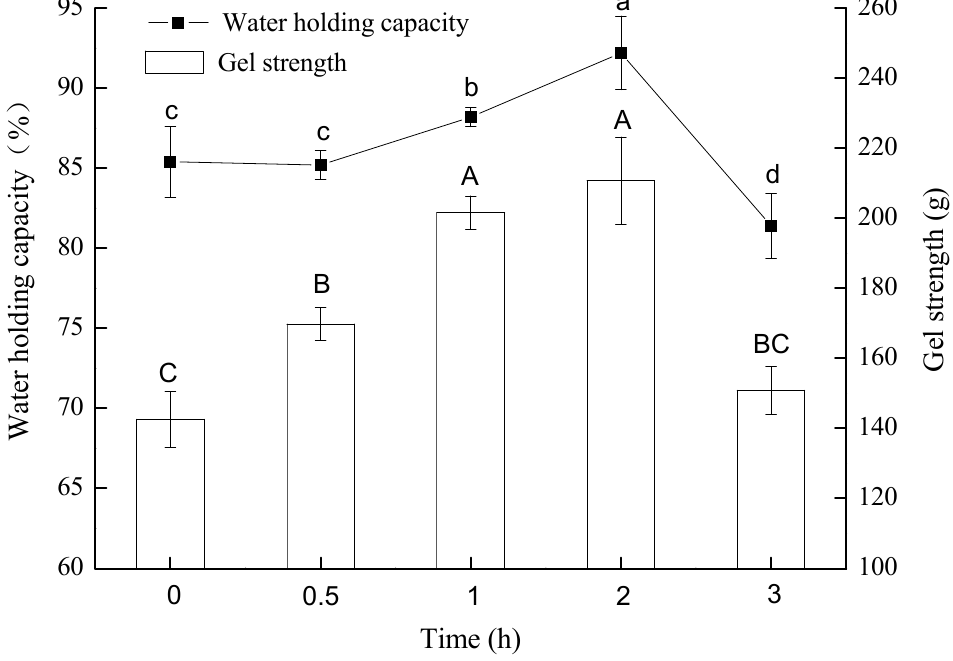
Figure 2. Changes in water holding capacity and gel strength of tofu prepared from soymilk with different TGase pre-crosslinking time spans (0, 0.5, 1, 2 and 3 h) and then coagulated by GDL. Means in the same plot that do not share a common superscript letter are significantly different ( p < 0.05).